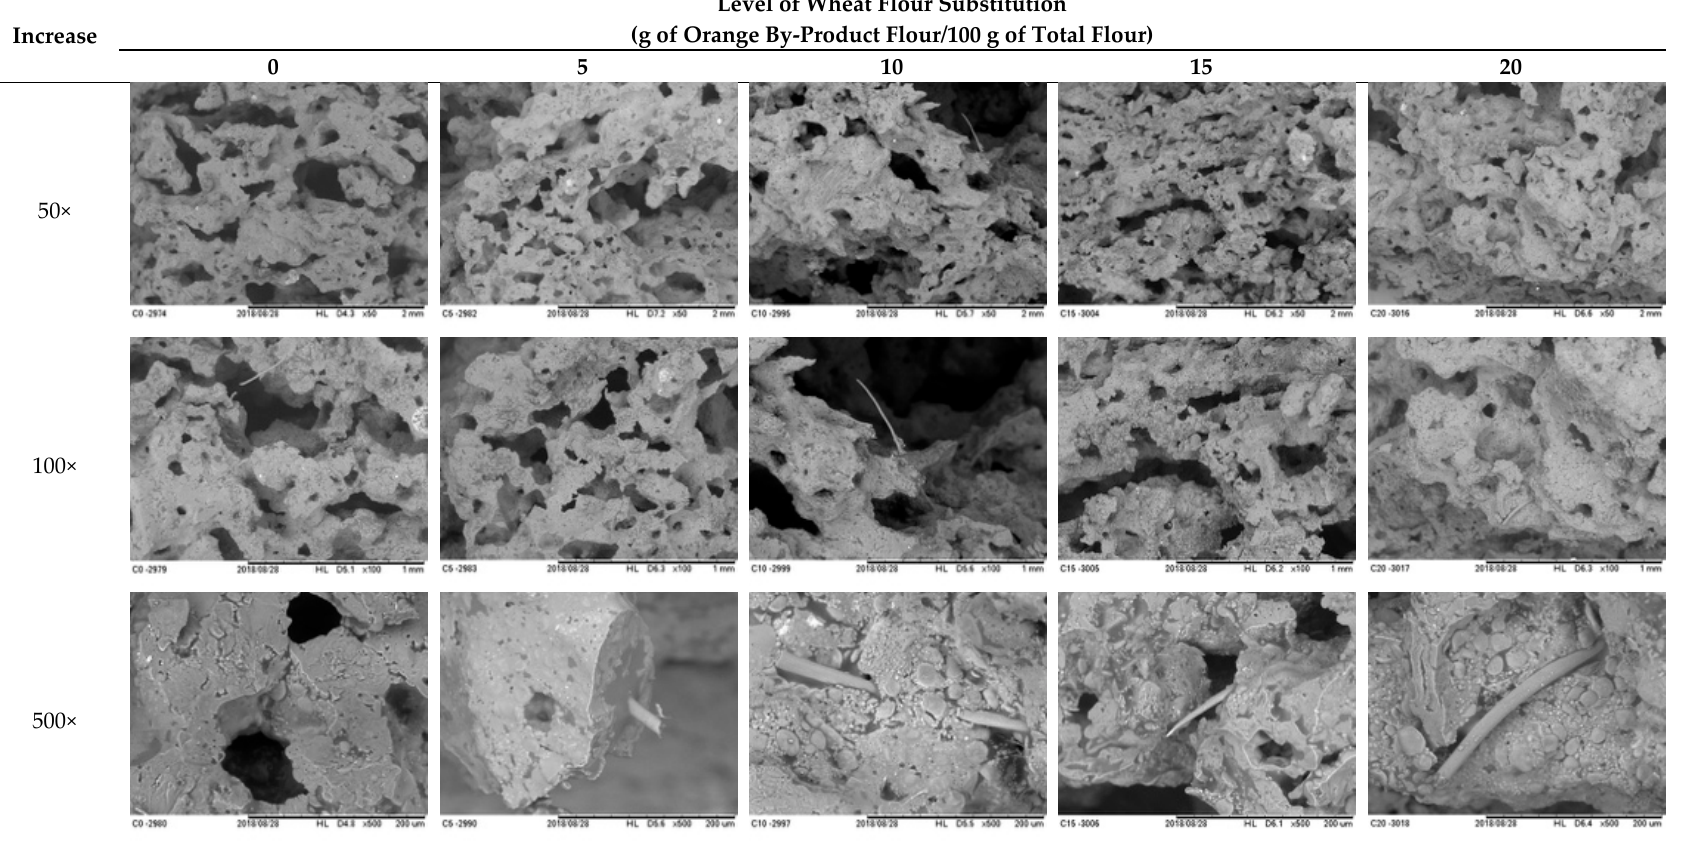
Figure 2. Images obtained from scanning electron microscopy (SEM) analysis of cookies produced by wheat flour substitution with orange by-product flour (OBPF), at magnifications of 50x, 100x and 500x.